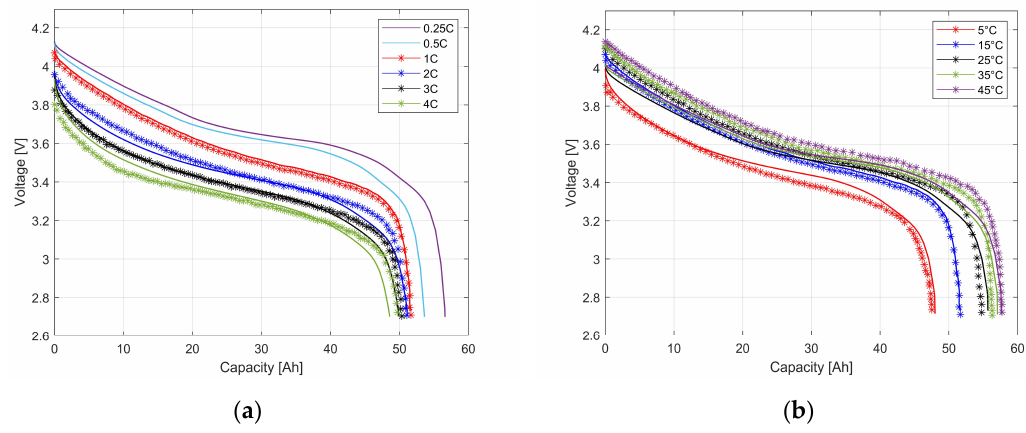
Figure 5. Battery model results (lines) with experimental data (markers) during discharge based on [72] ( a ): for different discharge-rates and T = 15 °C; ( b ) for different temperatures at 1 discharge rate.